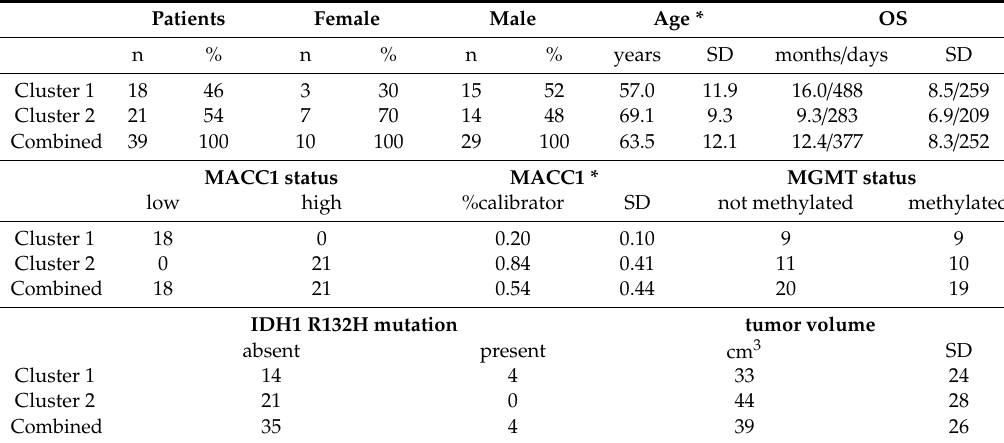
Table 2. Cluster